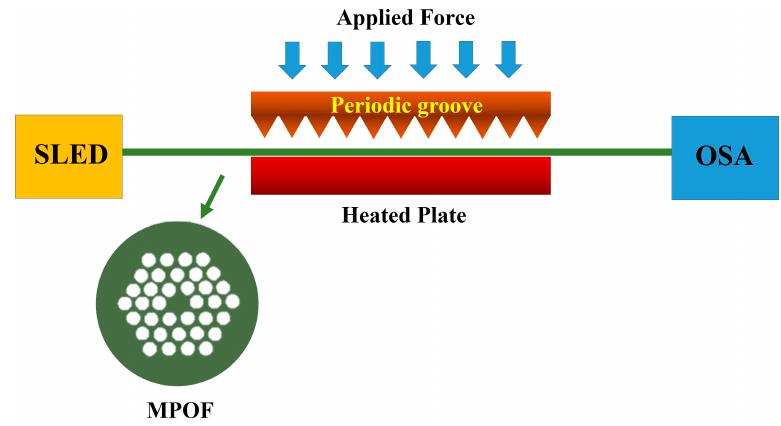
Figure 11. Schematic of mechanical-induced long period gratings (LPGs) in MPOFs.